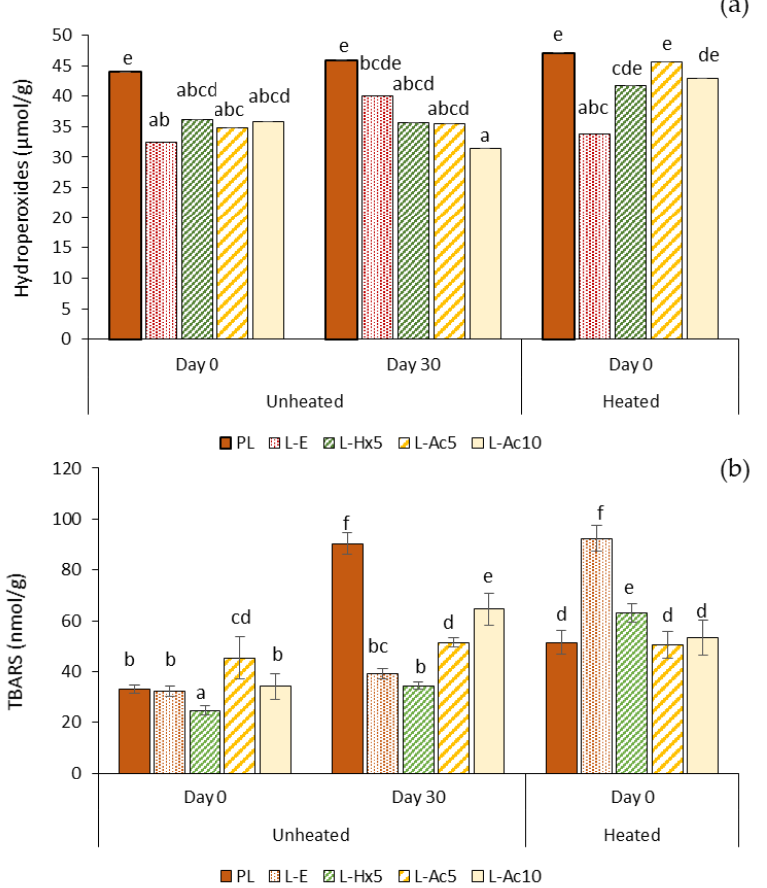
Figure 6. Oxidative stability in terms of ( a ) hydroperoxides formation and ( b ) TBARS accumulation in emulsions with addition of PL extract or liposomal dispersions. Different letters (a–e) indicate significant differences ( p ≤ 0.05).